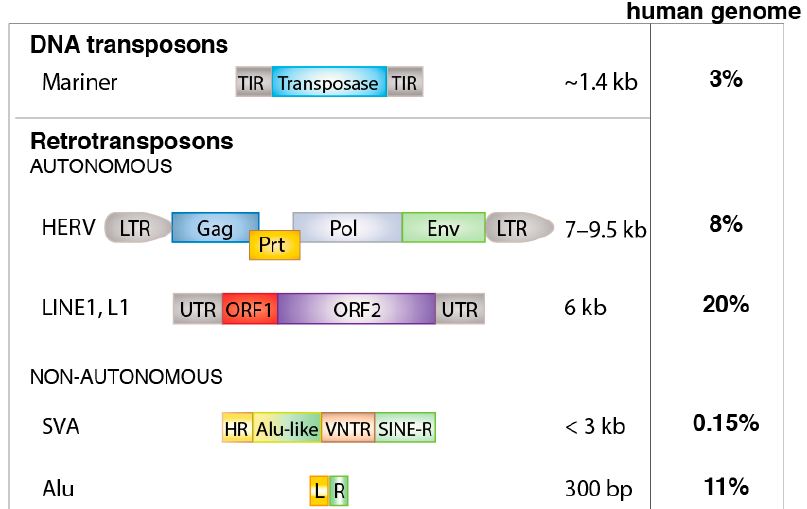
Figure 1. Classes and examples of transposable elements. Abbreviations: TIR, terminal inverted repeats; LTR, long terminal repeats (transcriptional control sequence); Gag, group antigen; Prt, protease; Pol, polymerase; Env, envelope; UTR, untranslated region; ORF, open reading frame; HR, hexamer repeat; VNTR, variable number tandem repeats; SINE-R, Alu right monomer; SVA, SINE-R/VNTR/Alu composite; L, left monomer; R, right monomer.